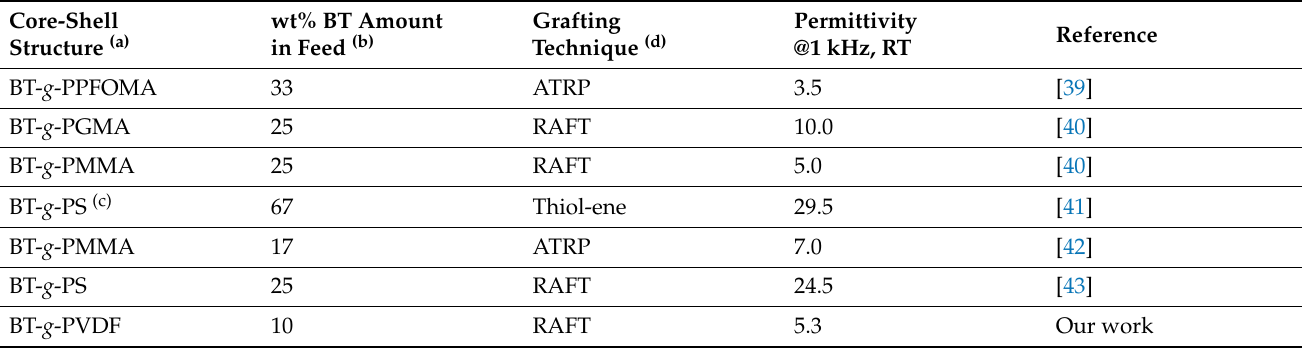
Table 2. Comparison of the permittivity of BT- g -PVDF 5.3 vol% sample with other BT- g -polymer reported in the